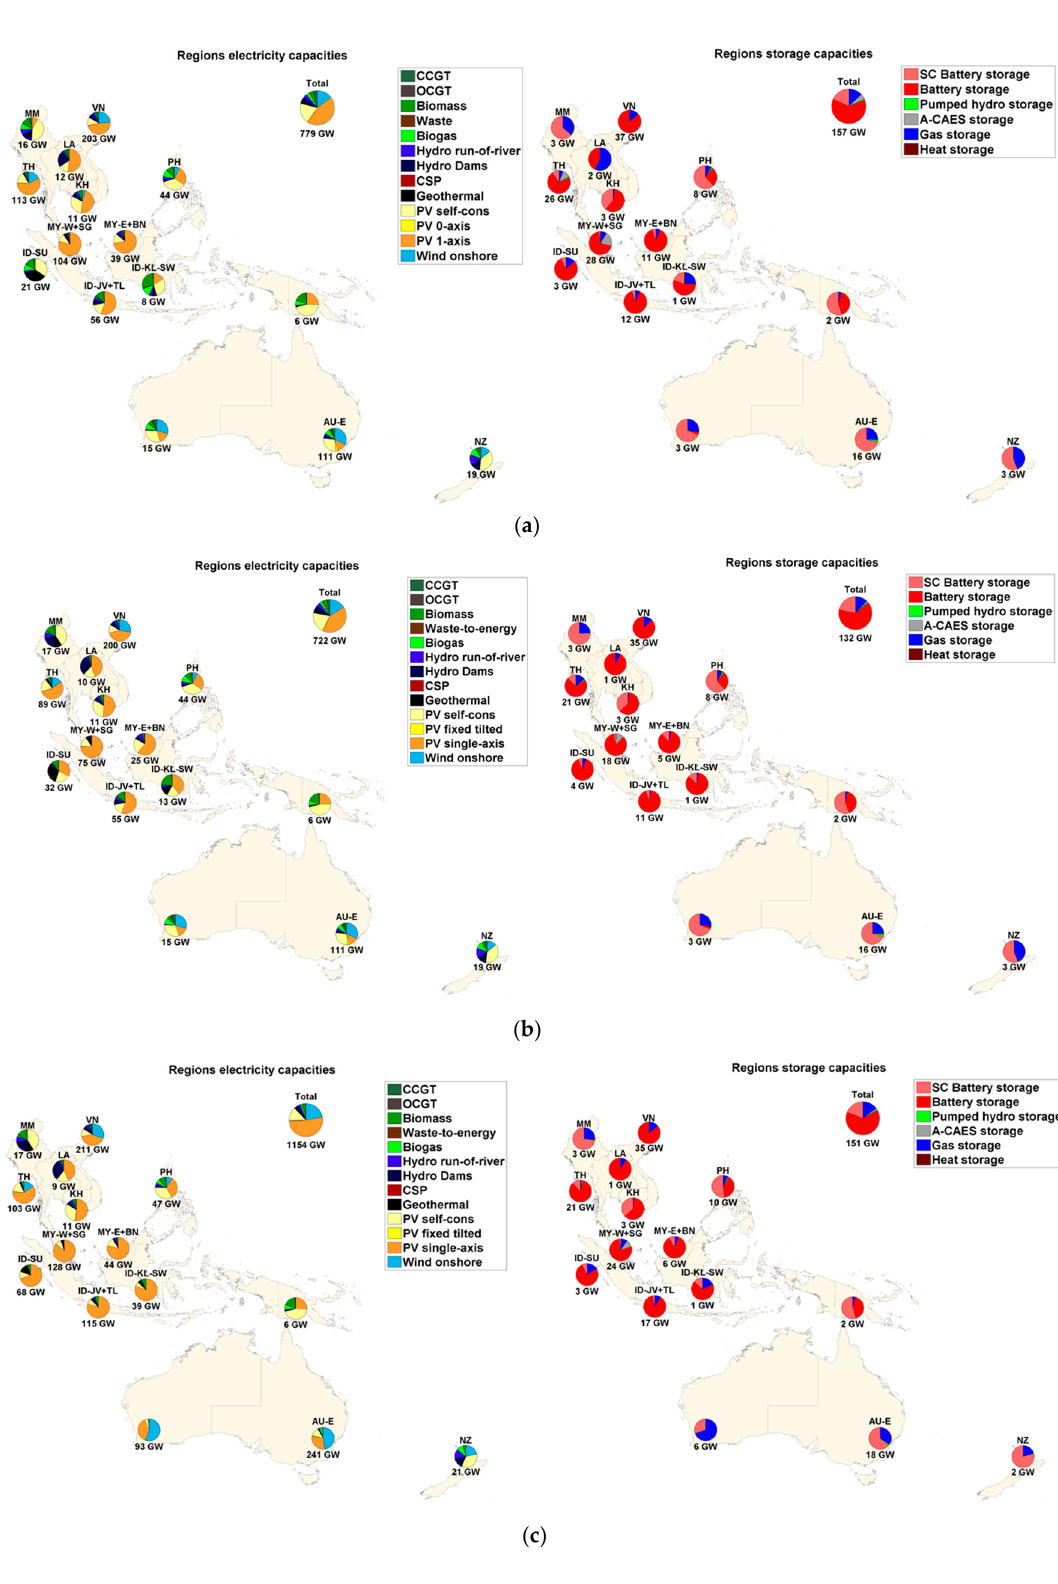
Figure 7. Installed capacities RE generation ( left ) and storage capacities ( right ) for: ( a ) region-wide; ( b ) area-wide; and ( c ) integrated scenarios for Southeast Asia and Pacific regions.